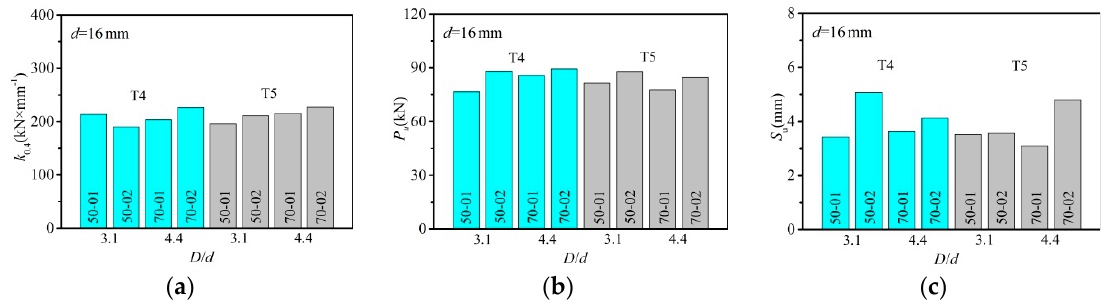
Figure 8. Effect of hole diameter ration ( D / d ): ( a ) shear stiffness; ( b ) shear capacity; ( c ) the maximum slip.